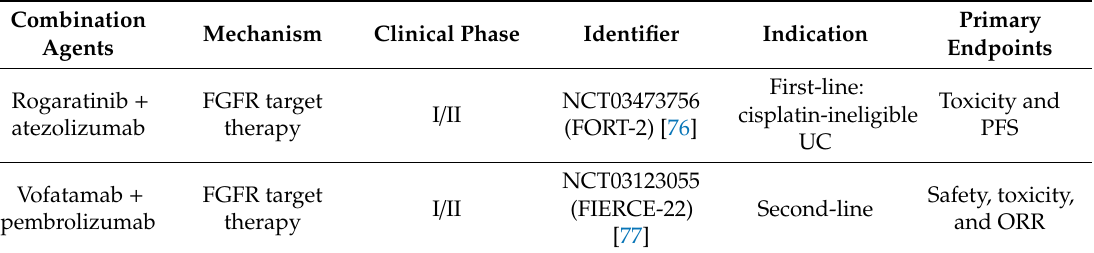
Table 6. Ongoing trials evaluating gene-targeted therapies for urothelial